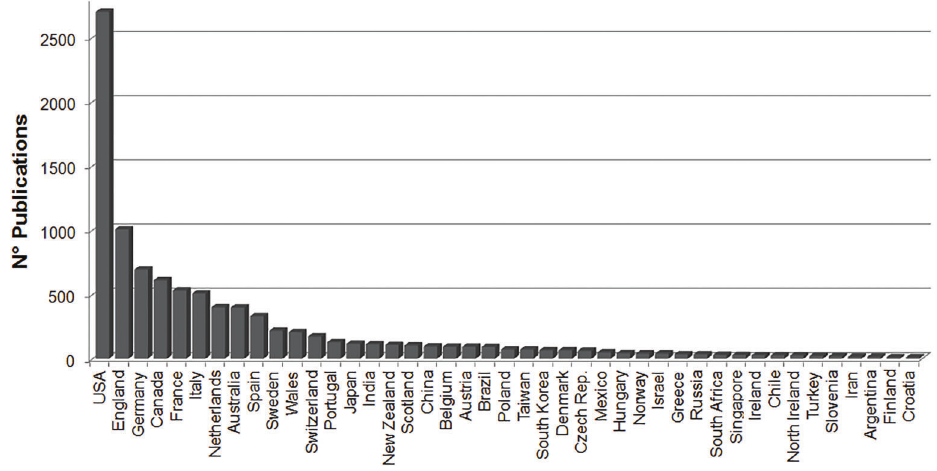
Figure 1. Countries with the highest percentage of publications (up to 10 publications included) on Huntington